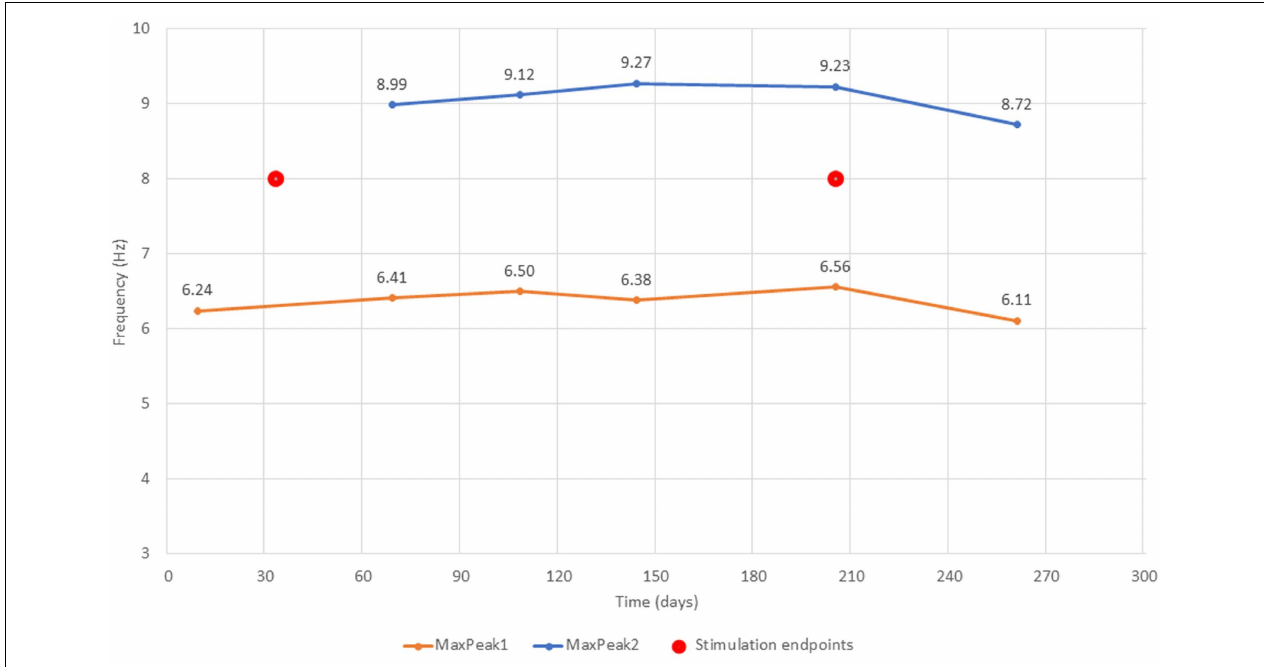
FIGURE 3 | The changes of MaxPeak1 and MaxPeak2 center frequencies across all six measurements. Captions accompanying the score points indicate the center frequency score. Stimulation endpoints (red circles) indicate the first and the last day of stimulation